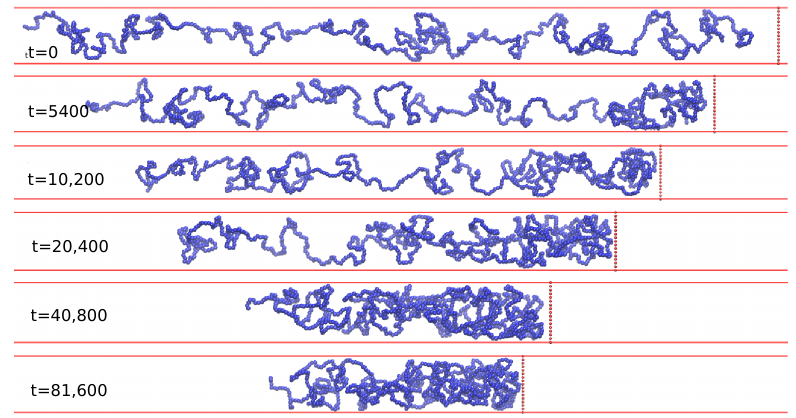
Figure 5. The corresponding snapshots of the simulated chain configuration for different c ( x , t ) in Figure